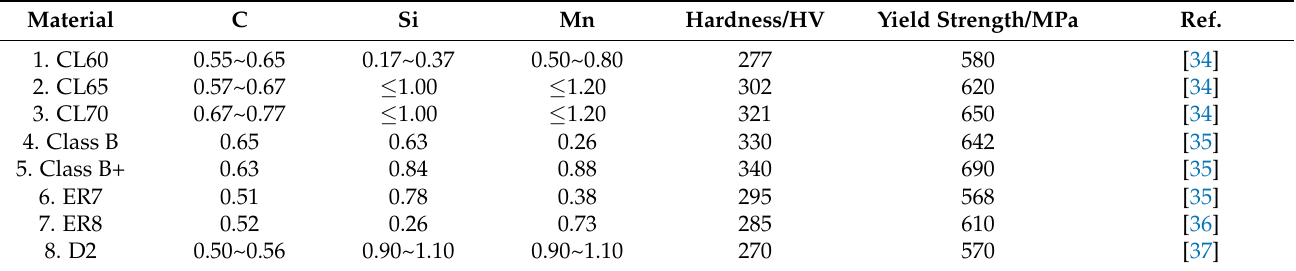
Table 2. Mechanical properties of the test steel. Table 3. Hardness, chemical composition (wt%) and yield strength of the representative wheel materials reported in previous studies. Yield Strength/MPa Tensile Strength/MPa